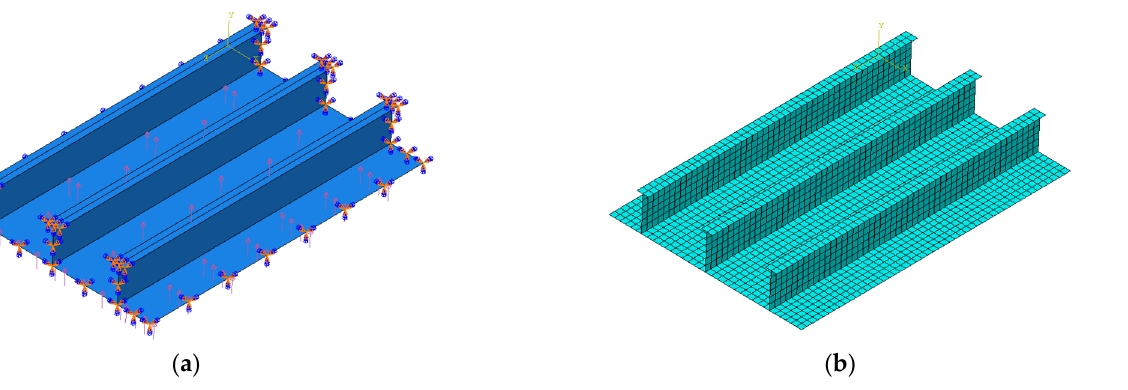
Figure 5. Modeled geometry with boundary conditions (all degrees of freedom in the boundary, i.e., connection with floors and girders are constrained) and uniformly distributed pressure load (with direction upwards) ( a ) and corresponding mesh ( b ) for the bottom stiffened panel.